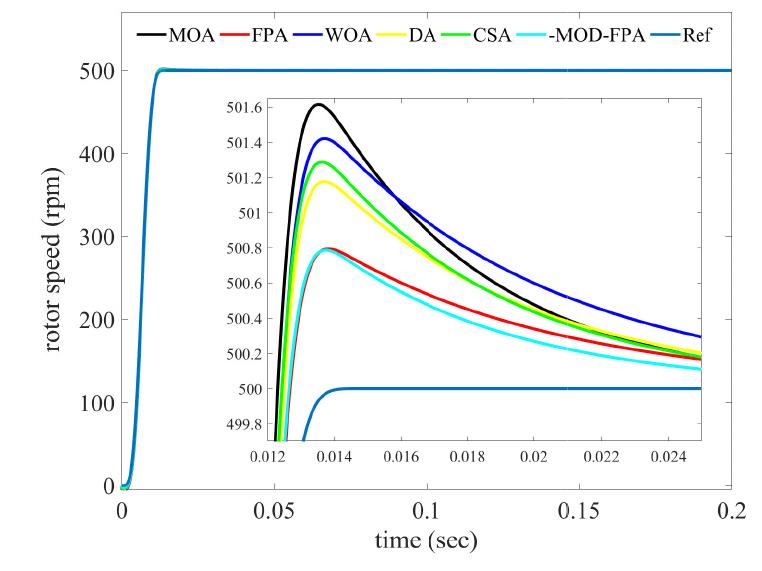
Figure 4. Simulation result for speed tracking task with constant load and nominal parameters